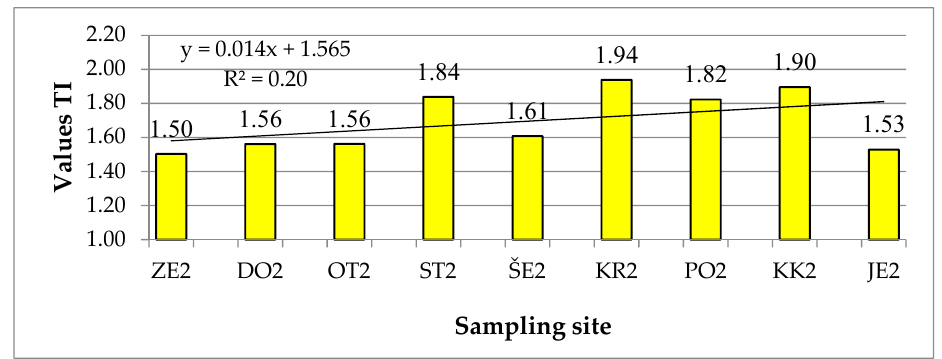
Figure 7. Trophic index for all summer samples (Sampling sites are defined in Figure 1).